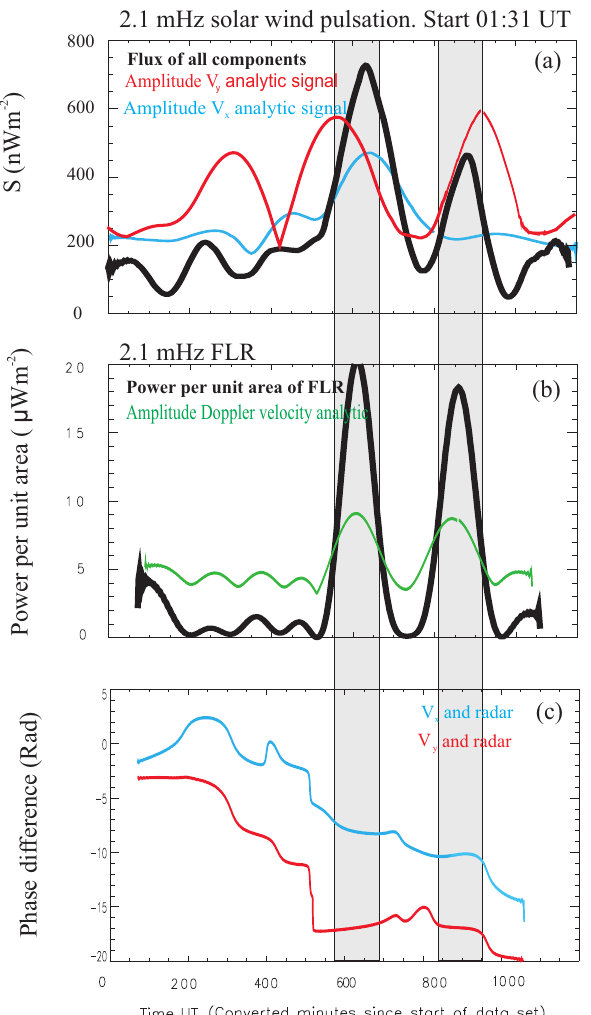
Fig. 8. (a) Amplitude of 2.1mHz solar wind velocity x and y components and energy flux of MHD wave in the solar wind. (b) 2.1mHz analytic signal and power power unit area of FLR. Start time 01:33UT, time adjusted by 57min in (a) and (b). (c) Cross phase of 2.1 mHz ACE Vx and radar analytic signals (blue) and ACE Vy and radar analytic signals